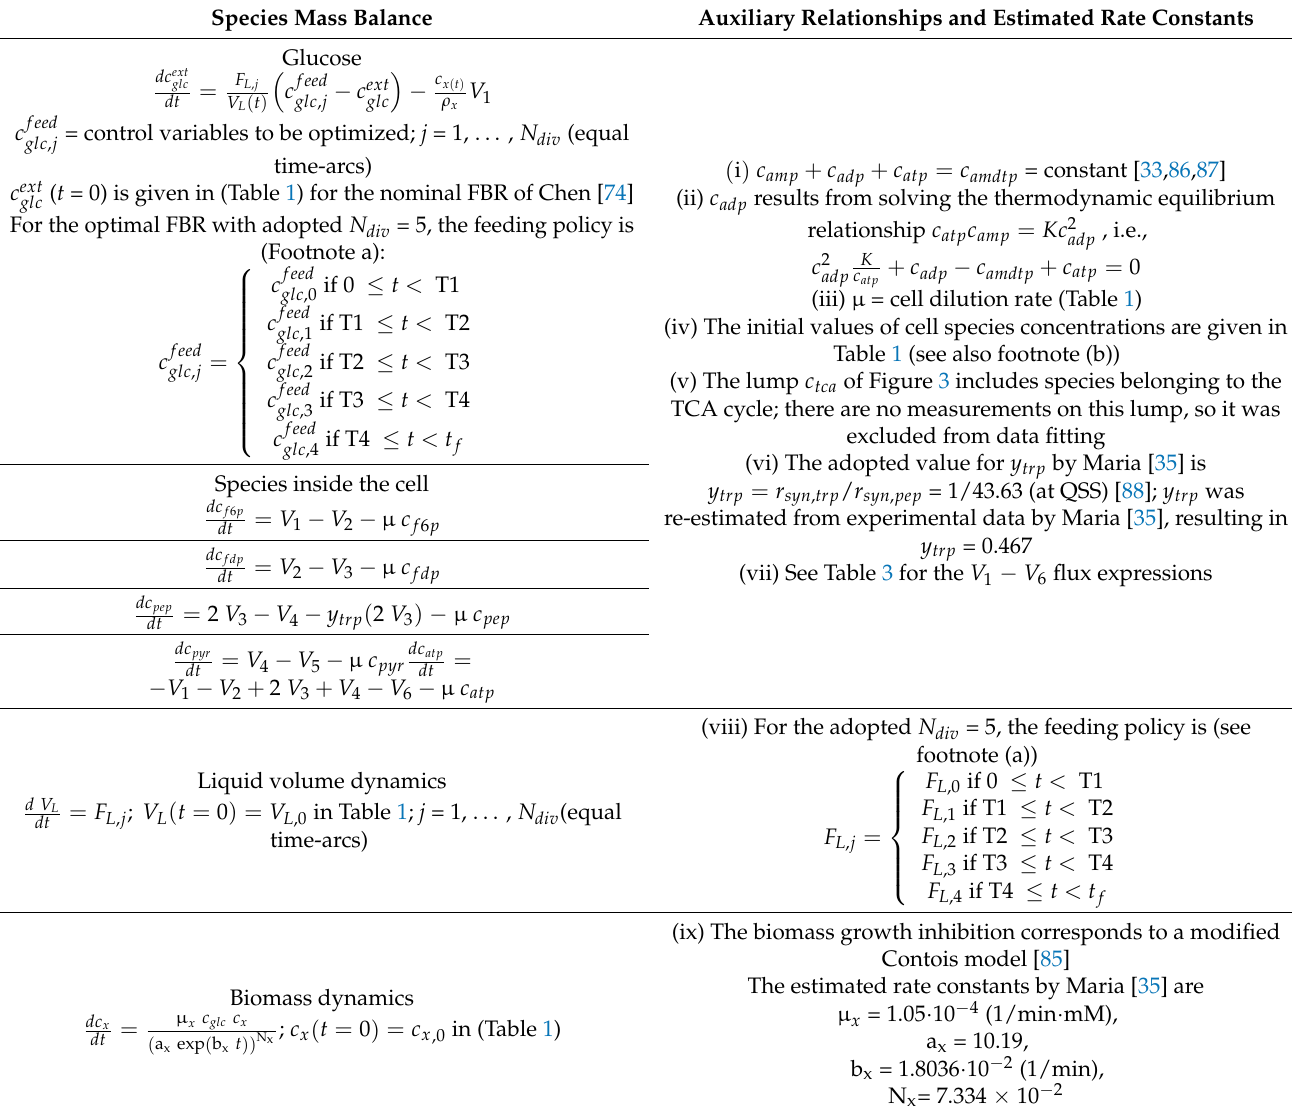
Table 2. Mass balance of the cell glycolytic key species and of the FBR control variables (GLC, F L ) for the optimally operated (time stepwise feeding policy) FBR, adapted from Maria